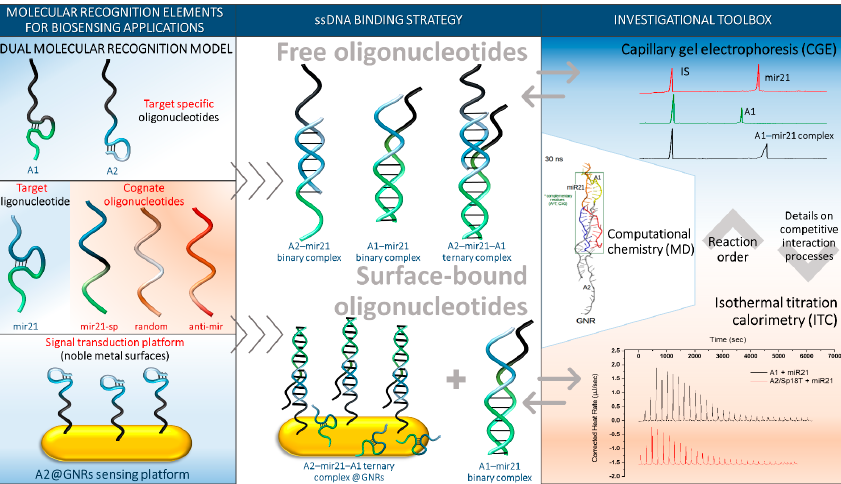
Figure 1. Schematic summary of the investigated scenarios and the employed analytical techniques.